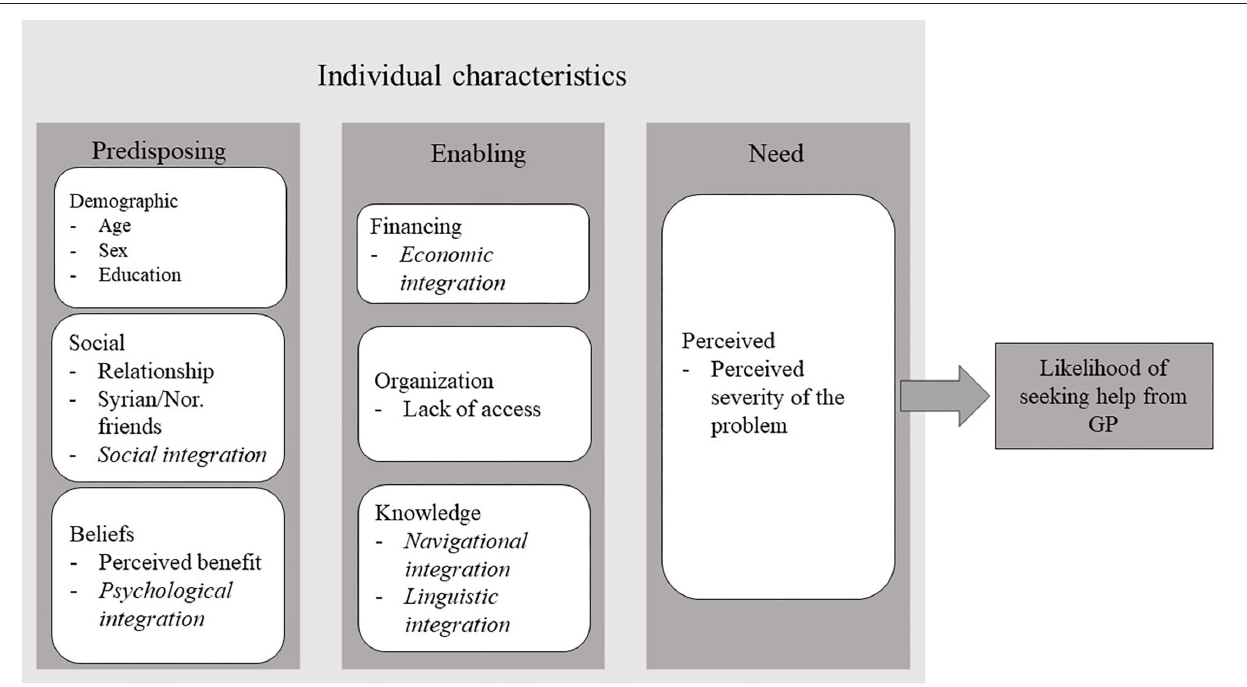
FIGURE 1 | Conceptual model of the current study based on Andersen’s behavioral model of health services use and Harder’s multidimensional measure of immigrant integration (in italics).